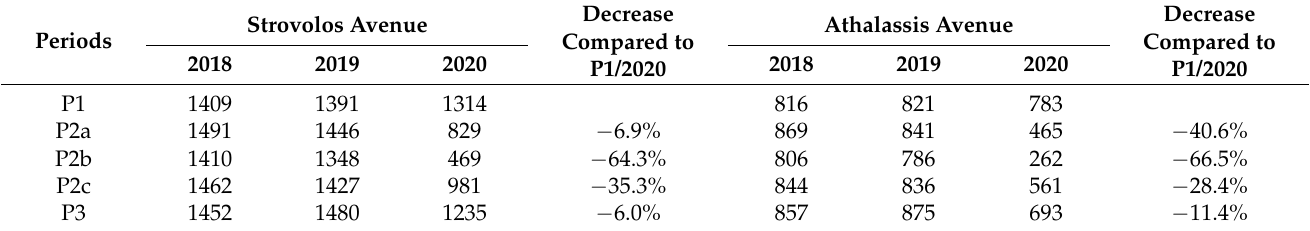
Figure 2. The hourly variation of the traffic load over the entire study period in ( a ) Strovolos Avenue and ( b ) Athalassis Avenue in 2020. The solid horizontal line illustrates the average number of vehicles where the percentages depict the corresponding load reduction per period in relation to the P1 period. The separation of periods is presented with a vertical black dashed line. Table 2. The average number of vehicles per hour passing through each avenue over the study periods in the years 2018, 2019 and 2020 along with the decrease in the average number of vehicles compared to P1/2020 where no lockdown measures were taking